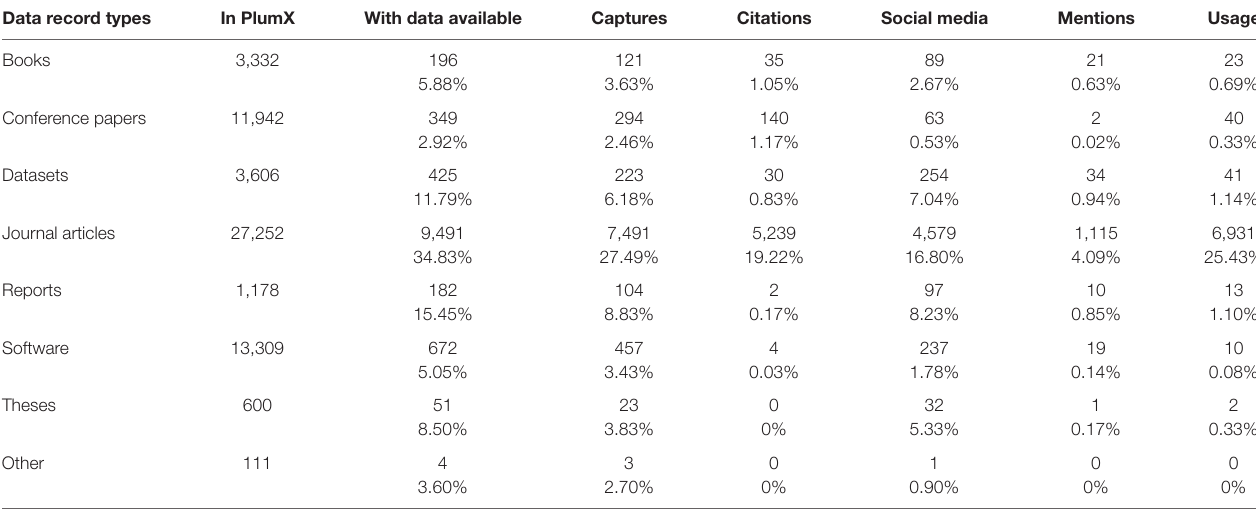
Table 6 | Results from PlumX: data availability for each Zenodo data record type (all publication